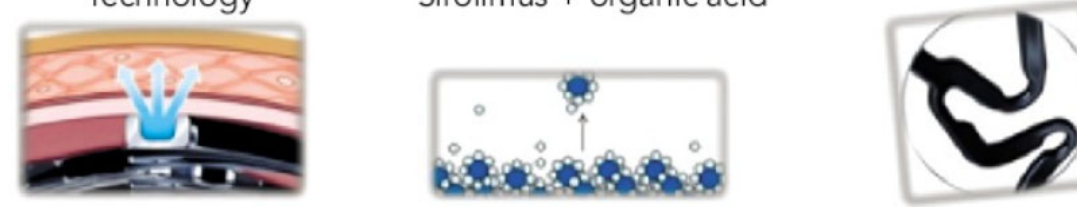
Figure 2. Features of Cre8 eluting stent. Polymer ‐ free platform with abluminal reservoir technology as a drug delivery system for amphilimus distribution to the arterial wall and Bio Inducer Surface (BIS) with anti ‐ thrombotic and healing properties [29].